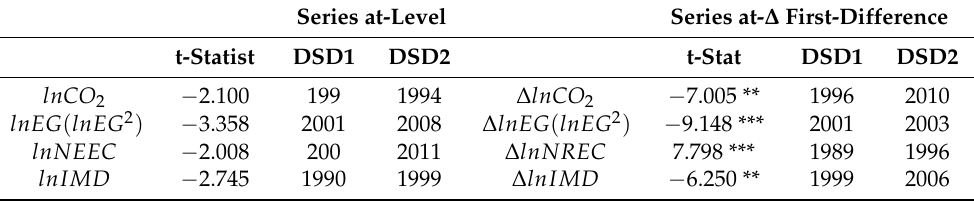
Table 2. Findings of CMR test.